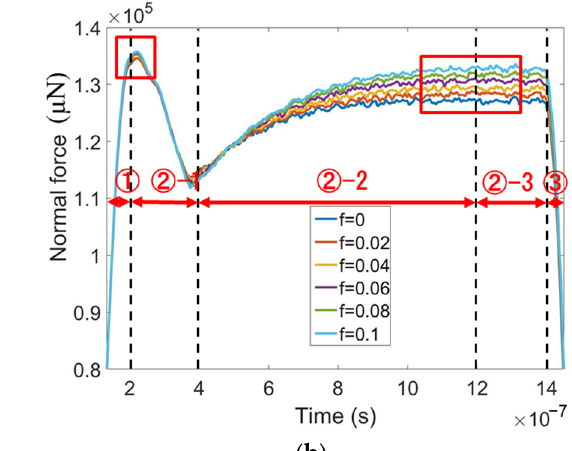
Figure 10. The evolutions of ( a ) contact area and ( b ) normal force with time at various friction coefficients for edge-leading Berkovich scratching.